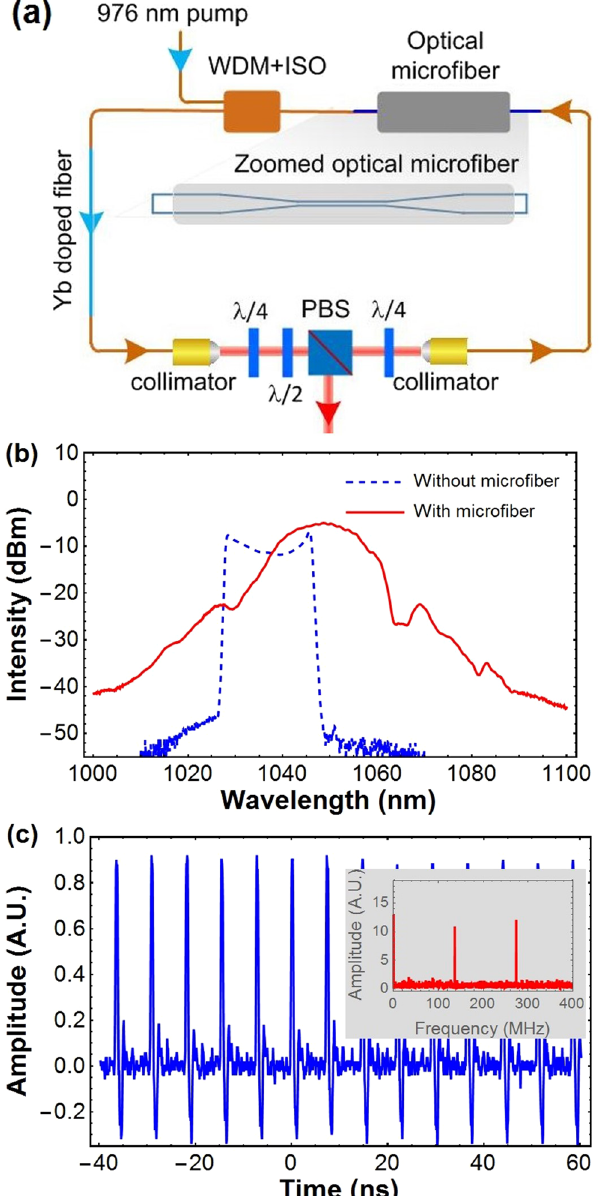
Figure 2. ( a ) Schematic for an ultrafast fiber laser incorporating an optical microfiber for dispersion management. The pump at 976 nm entered the laser cavity via a 980/1060 nm WDM/Isolator hybrid and pumped a 15 cm-long Yb doped fiber (Yb1200, Liekki). The waveplates and the PBS between the two collimators worked as an artificial fast saturable absorber for the mode-locked laser operation via nonlinear polarization evolution. A sealed optical microfiber was spliced with negligible optical losses for cavity dispersion management. The zoomed-in figure shows the details of the sealed optical microfiber. ( b ) Typical output optical spectrum at a pump power of about 150 mW for the laser cavity incorporated with a 25 cm long optical microfiber with a diameter of about 1 μ m. Also showed the dashed blue line standing for the laser without the optical microfiber, for a comparison. ( c ) The waveform from a 1 GHz photodetector displayed on a 6 GHz- bandwidth oscilloscope. The Fourier-transform spectrum shows as the inset, with a fundamental frequency of 120 MHz, corresponding to a cavity length of 1.7